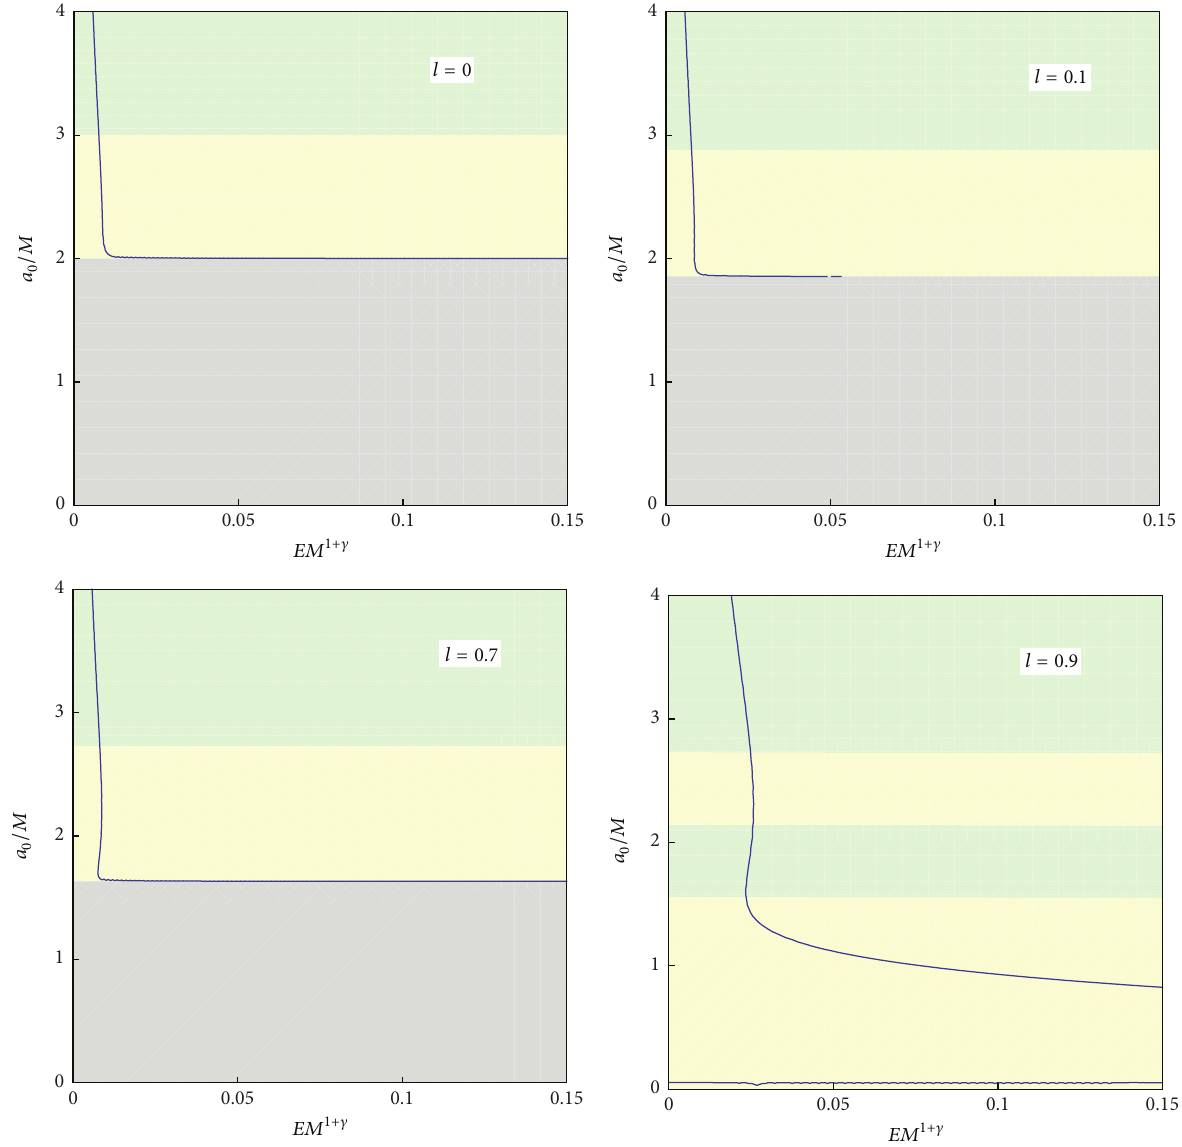
Figure 8: Plots corresponding to MCCG with parameters 𝛾 = 0.6 , 𝑀 = 1 , 𝐴 = 1 , and 𝑤 = −10 and different values of 𝑙 .